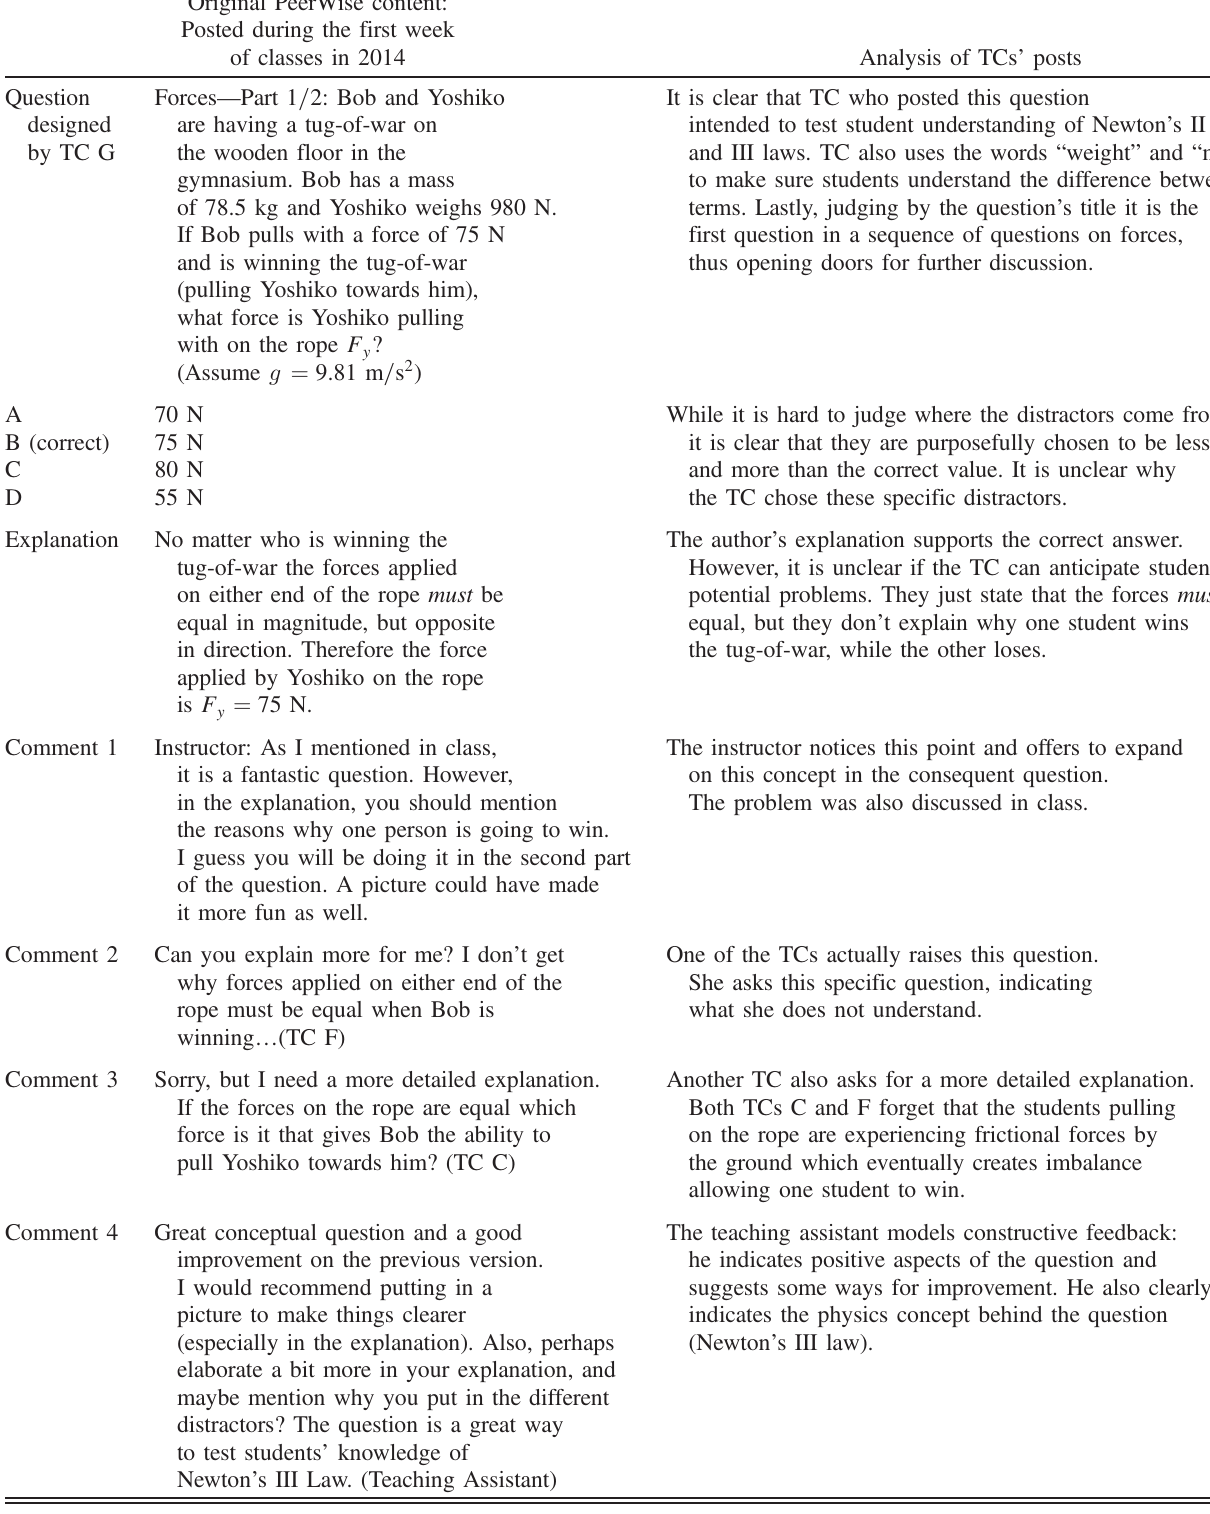
TABLE I. An example of a PeerWise question posted by a TC in the fall of 2014 and of the discussion that followed. Our interpretation of this development is posted in the right